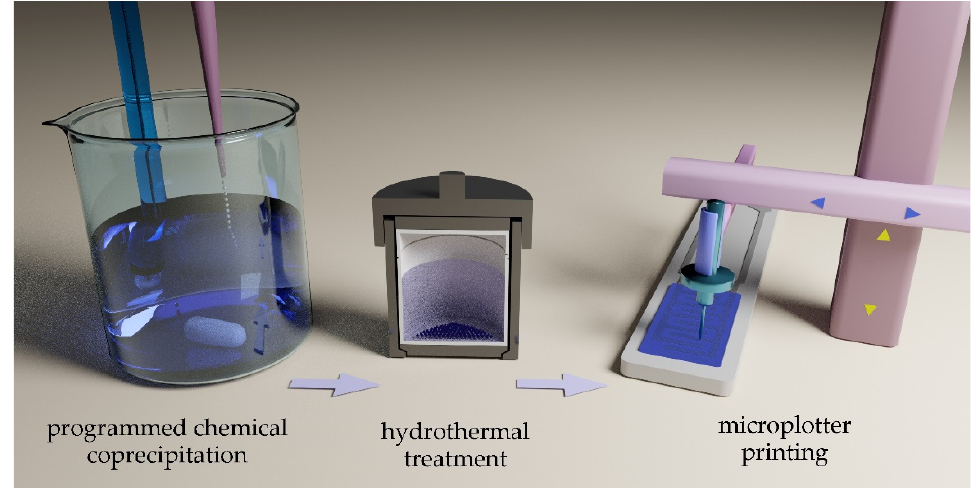
Figure 1. Schematic illustration of hierarchically organized oxide synthesis and microplotter printing of the corresponding film on a chip.